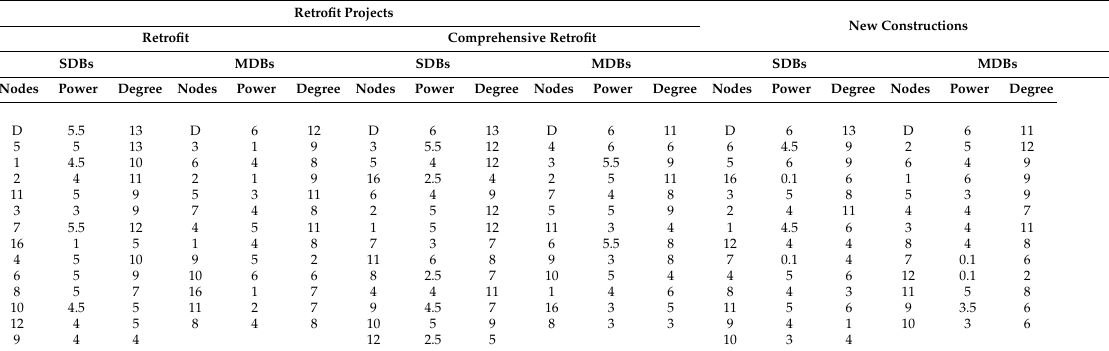
Table A5. Numerical output stakeholder networks classified according to building typologies and project types in Germany (DE).